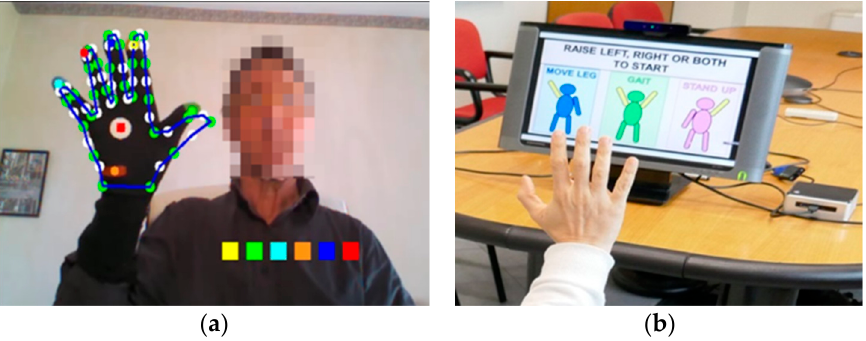
Figure 3. Example of the human machine interface. ( a ) Graphical user interface (GUI) for color calibration procedure (upper limb subsystem) and ( b ) GUI for task selection (lower limb subsystem).